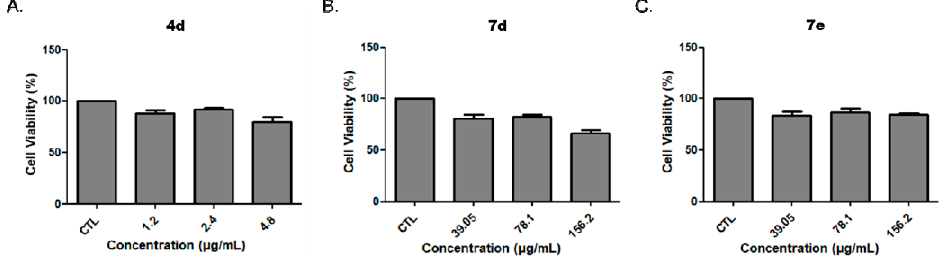
Figure 3. Viability assay of HaCaT cells with different doses of compounds. ( A ) Compound 4d ; ( B ) compound 7d ; ( C ) compound 7e . Cell viability is measured by CCK-8 assay compared to the control (CTL) group. Results are expressed as the mean ± SEM ( n = 3).